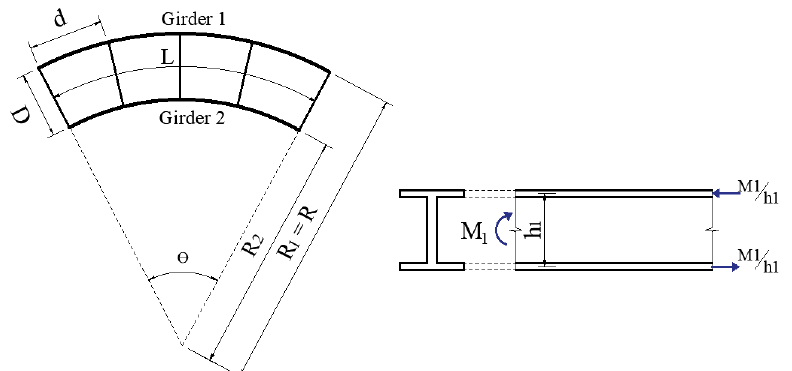
Figure 2. (a) Segment of a curved bridge with two girders; (b) Longitudinal bending and flange forces acting on girder 1. Adapted from Fiechtl et al. [11].